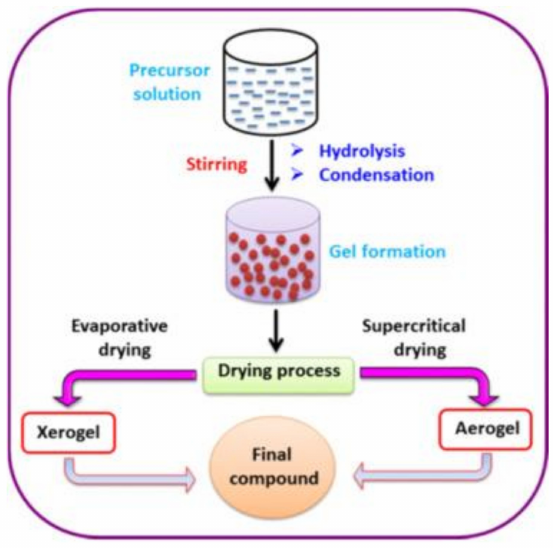
Figure 8. The reaction pathway involved in sol-gel synthesis of metal oxide nanostructures. Reprinted with permission [74]; 2017,